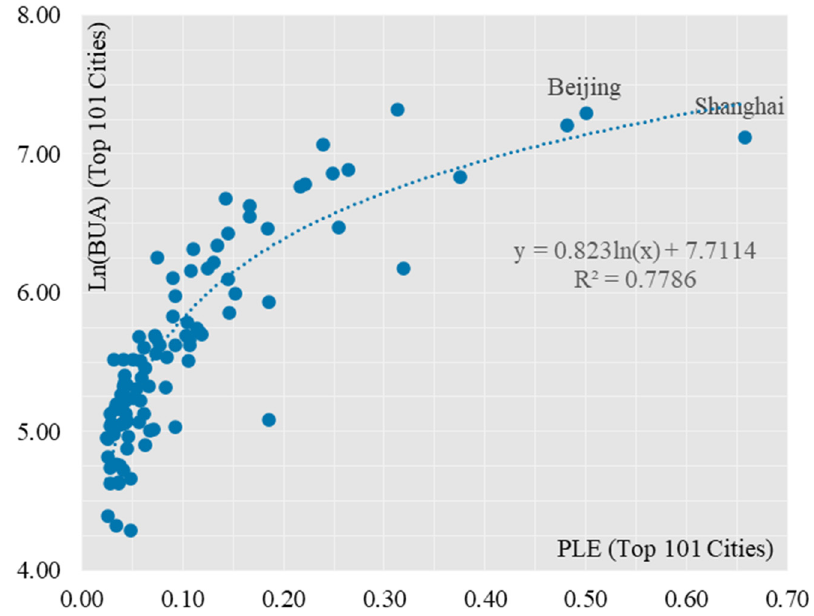
Figure 5. Scatterplot of two variables PLE and BUA (analysis of 101 large cities).